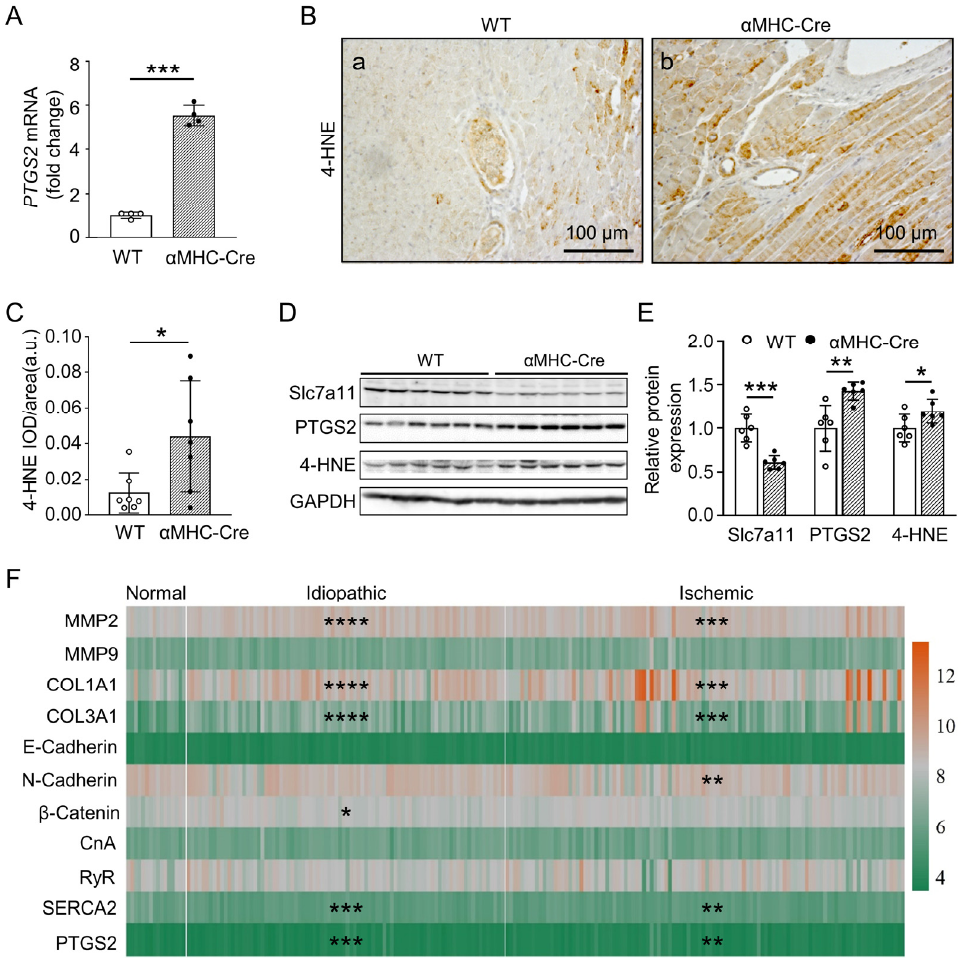
Figure 7. Ferroptosis signaling pathway is involved in Cre recombinase induced cardiotoxicity. ( A ) Relative levels of PTGS2 mRNA were measured in left ventricular from WT and α MHC-Cre mice at six months of age using real-time PCR. Gene expression changes are presented as a fold change relative to WT controls (n = 4 mice per group). ( B ) Representative images of 4-HNE immunohisto- chemical staining of left ventricular sections from six-months-old WT (a) and α MHC-Cre (b) mice. ( C ) 4-HNE intensity was determined and quantified by Image J. a.u., arbitrary units. ( D and E ) Western blot and quantitative analysis of Slc7a11, PTGS2 and 4-HNE, GAPDH as the loading control in left ventricular derived from six-months-old WT and α MHC-Cre mice (n = 6 mice per group). ( F ) Heat map of differential genes expression in human normal heart tissue or heart failure (idio- pathic or ischemic cardiomyopathy) samples from GSE5406. n (Normal: non-failing heart) = 16; n (Idiopathic failing heart) = 86; n (Ischemic failing heart) = 108. For A, C and E, each dot represents one individual. Statistical significance was determined using two-tailed Student’s t-tests. * p < 0.05, ** p < 0.01, *** p < 0.001, **** p < 0.0001.